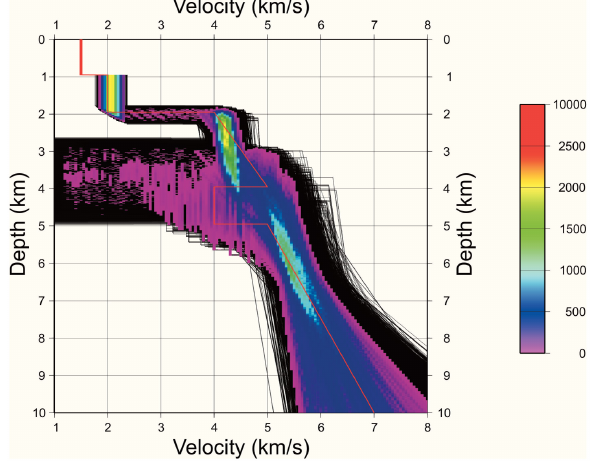
Fig. 15. Results obtained after using the Metropolis algorithm on data from model 1 and 20Hz for 40000 cases. Red line represents the real model and every black line a modified model. The colour scale stands for the number of times that a model (or part of it) is visited. The preferred model consists in a velocity gradient which includes basalt, sub-basalt and basement layers. The sub-basalt low velocity layer is reasonably well recovered in velocity and thick- ness.